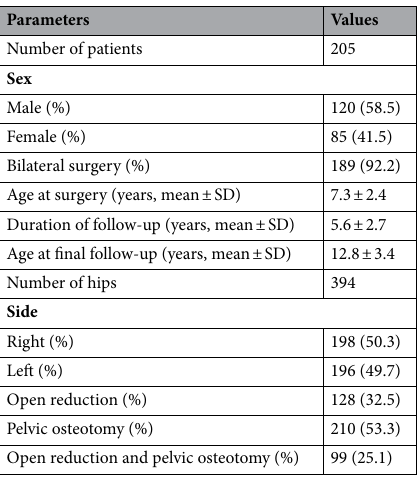
Table 1. Data on the